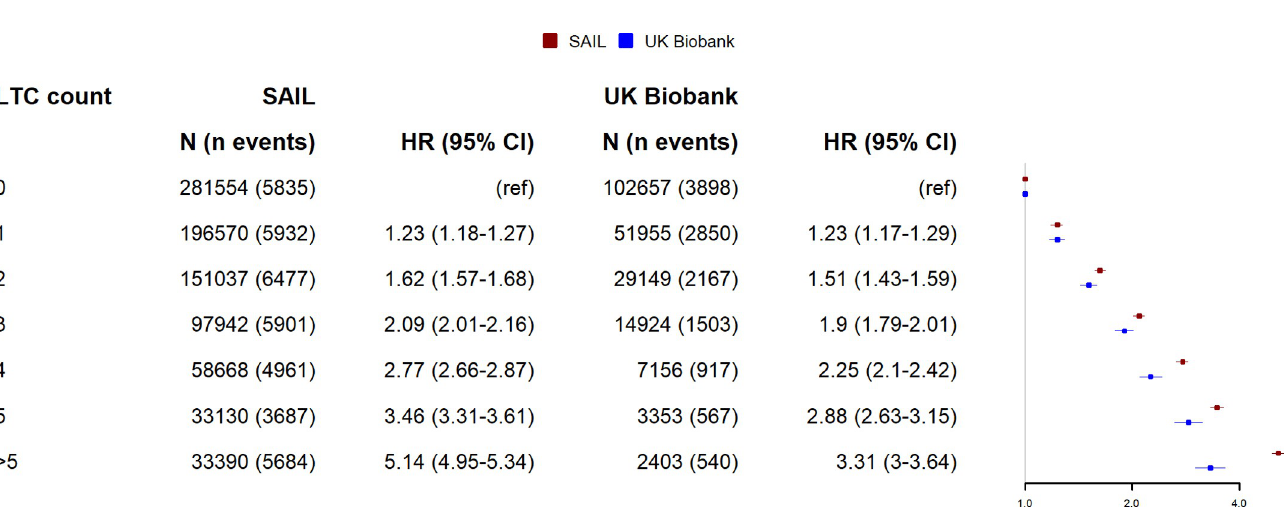
PLOS Medicine| https://doi.org/10.1371/journal.pmed.1003931 March 7,